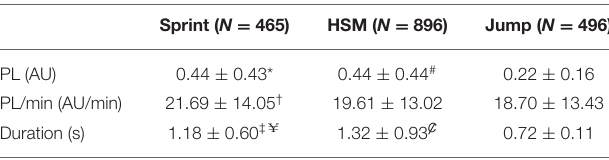
TABLE 2 | Activity frequency and mean ± standard deviation for all variables in each activity